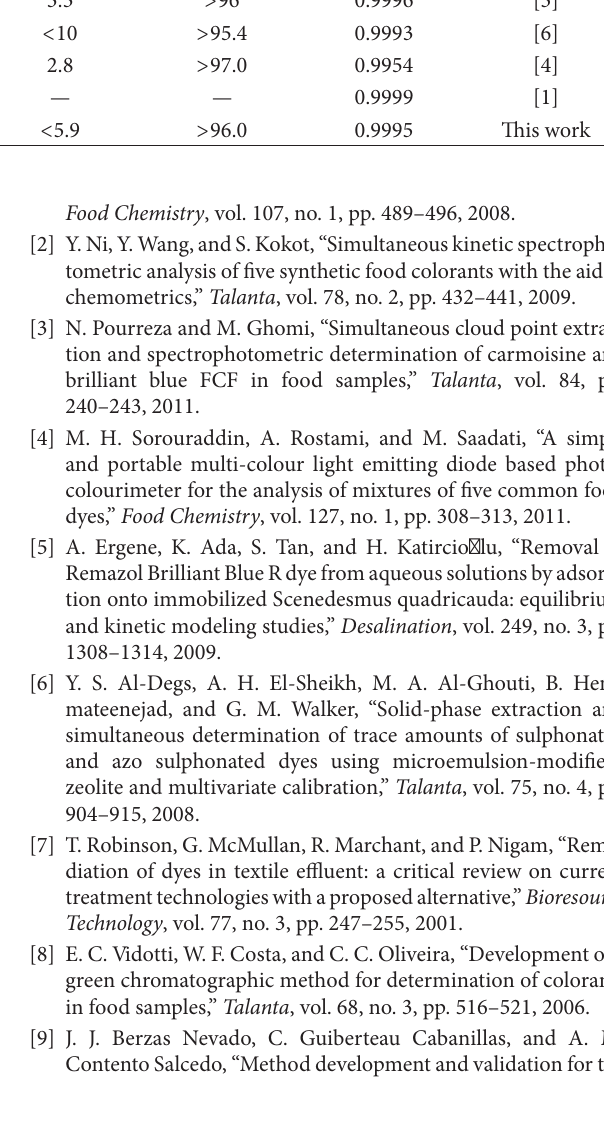
T 3: Comparison of different methods for the determination of brilliant blue FCF by aqueous two phase system.